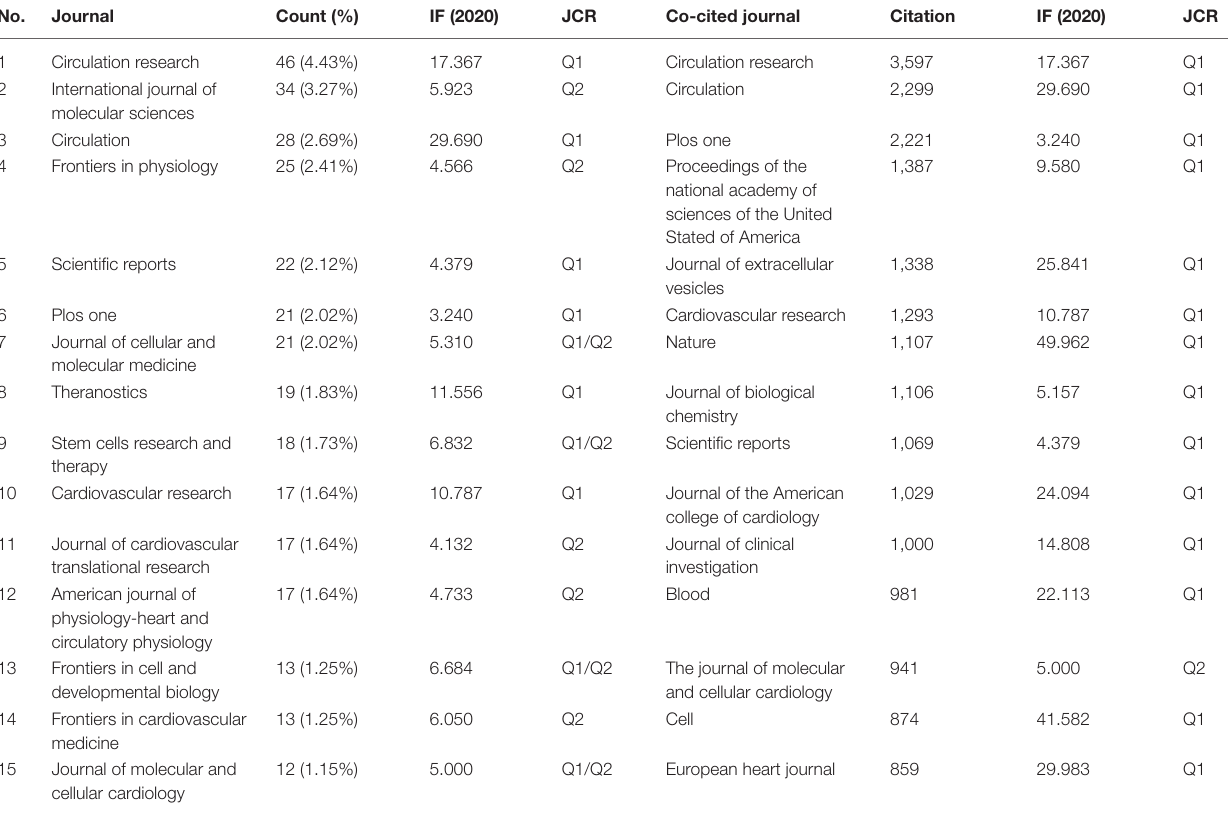
TABLE 2 | Top 10 journals and co-cited journals related to exosomes in CVDs.